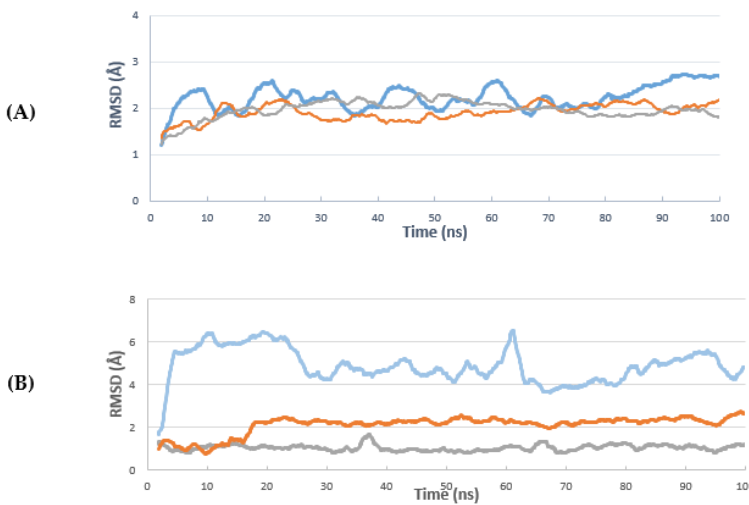
Figure 9. The root-mean-square deviation (RMSD) curve ( A ) curve of the deviations complex with bikaverin (blue line), ellagic acid (brown line), and emodin (gray line). RMSD indicates root-mean-square deviation protein C-alpha atoms, where the moving average over 20 frames is shown for clarity. ( B ) The ligand RMSD curves centered to protein, bikaverin (blue line), ellagic acid (brown line), and emodin (gray line). RMSD indicates root-mean-square deviation of ligand heavy atoms, where the moving average over 20 frames is shown for clarity.